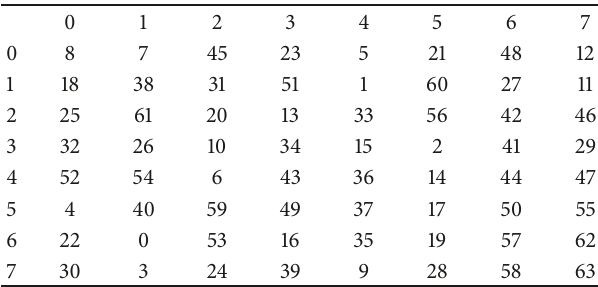
Table 6: The proposed 6 × 6 substitution-box.